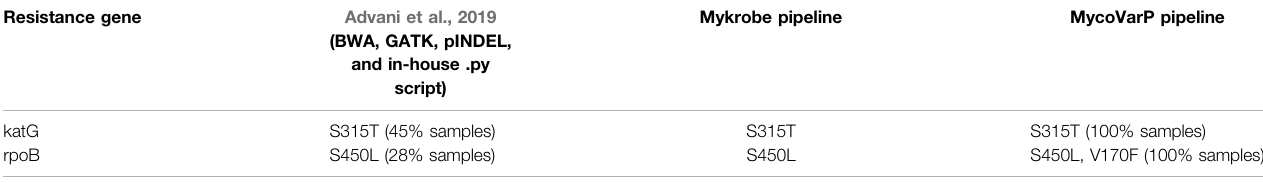
TABLE 2 | SNVs with a high mutation rate in katG and rpoB were reported by Advani et al., 2019. The same mutations were observed and correlated using Mykrobe and MycoVarP pipelines. The results obtained by MycoVarP are supported by the existing pipeline and published data.